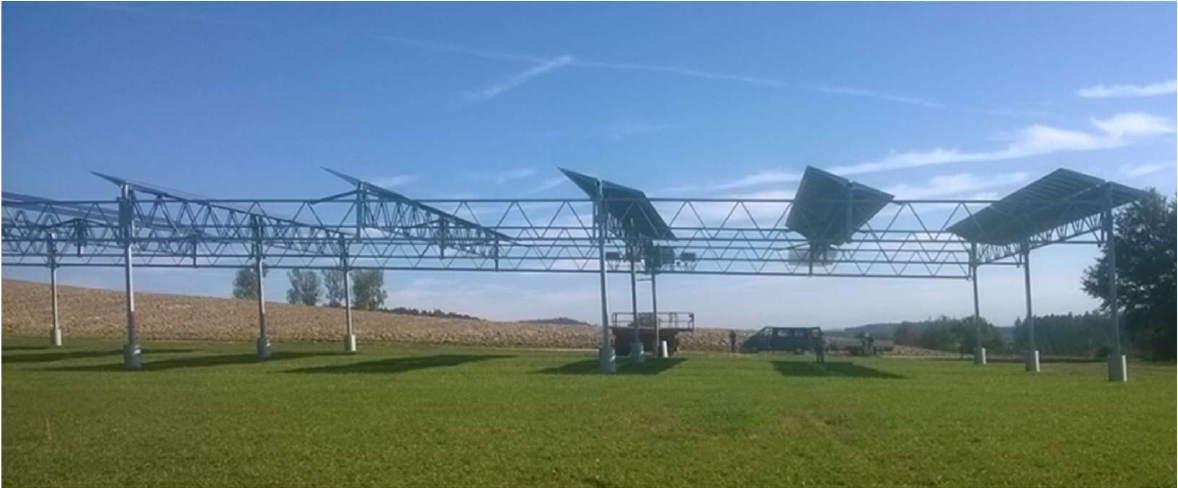
Figure 12. Impression of an experimental agrivoltaic system.